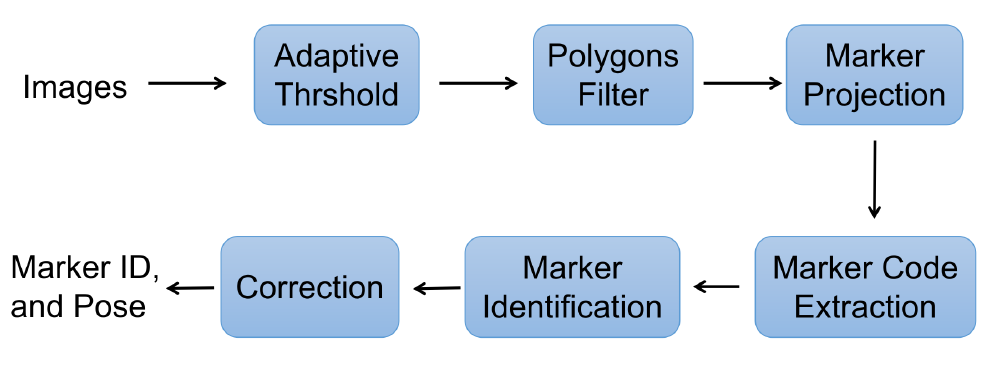
Figure 1. The ArUco